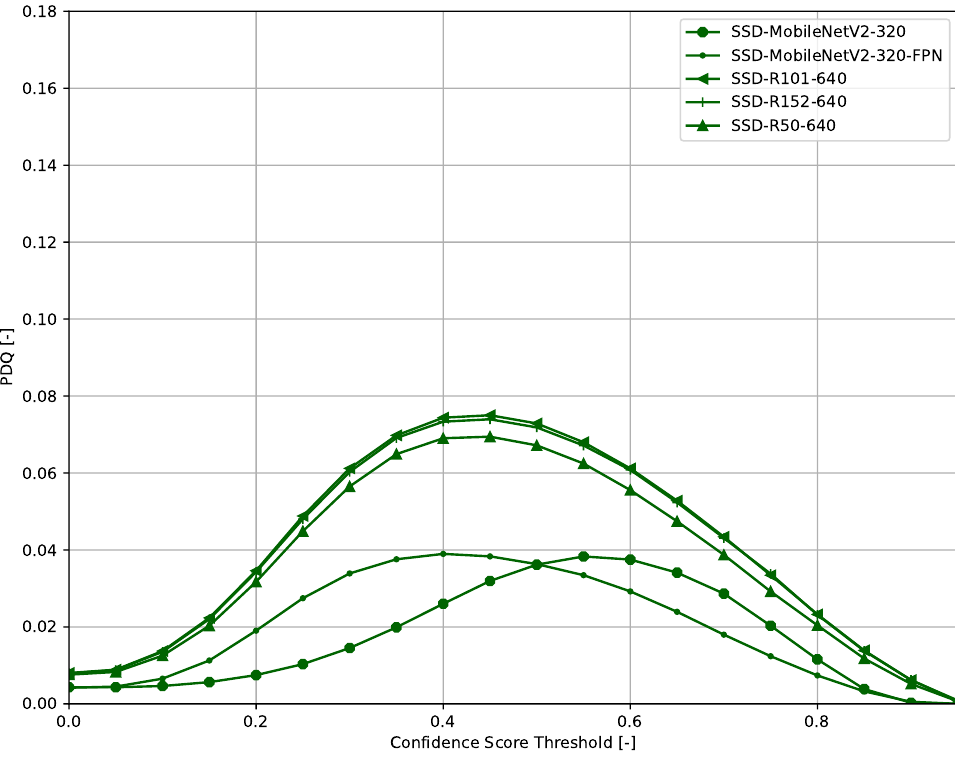
Figure 12. PDQ results of SSD on the COCO dataset.